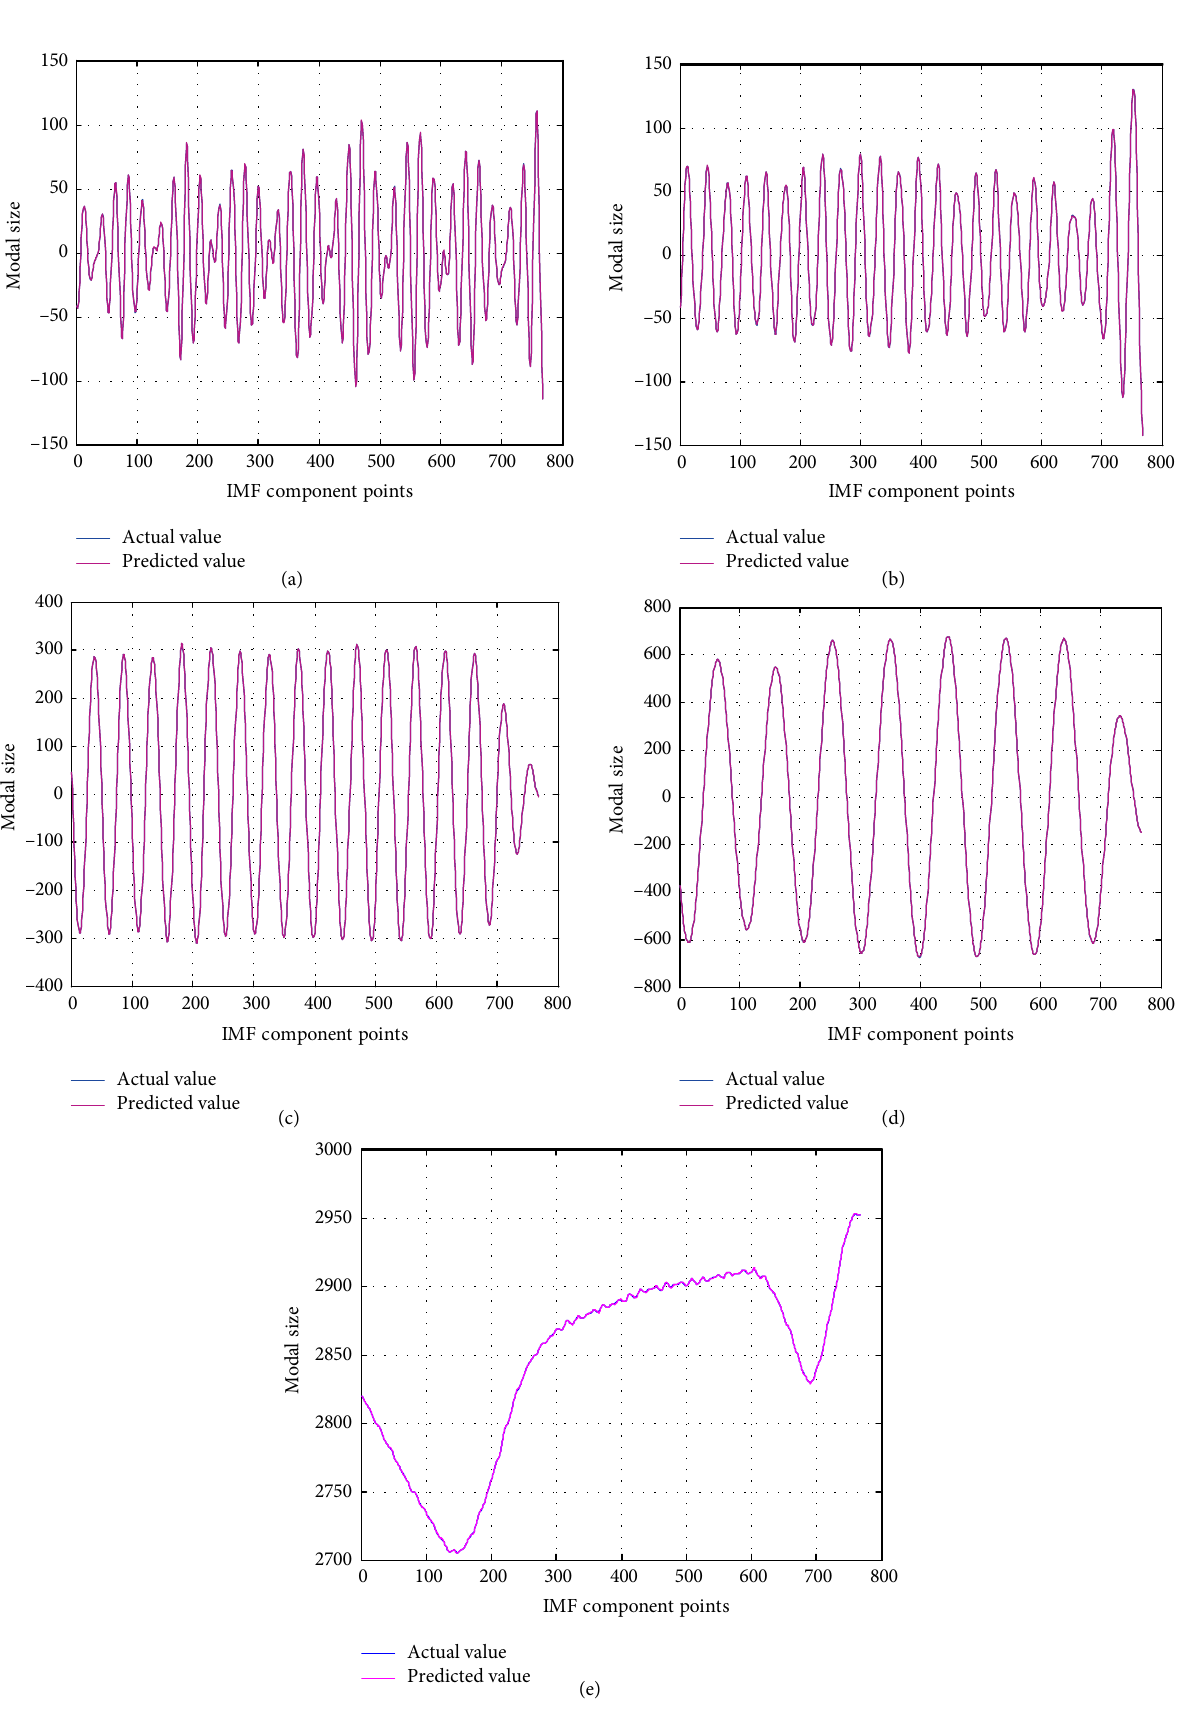
Figure 9: Intermediate frequency and low frequency component prediction figure. Prediction results of (a) IMF6, (b) IMF7, (c) IMF8, (d) IMF9, and (e)